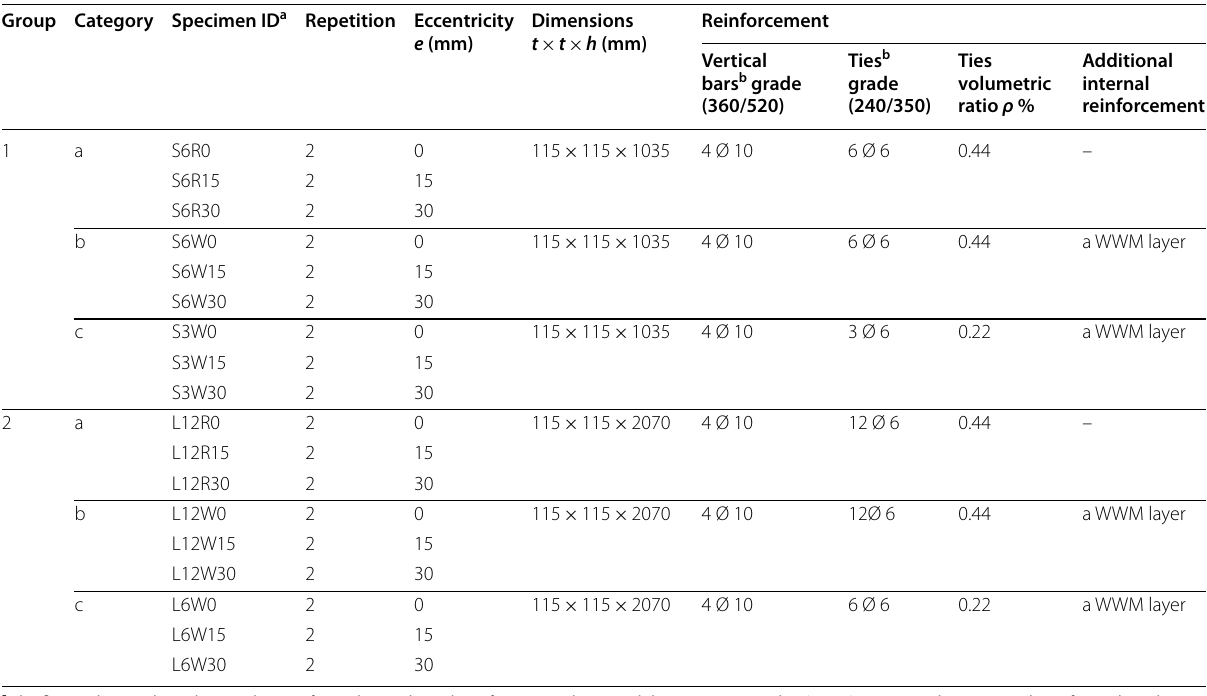
Group Category Specimen ID a Repetition Eccentricity